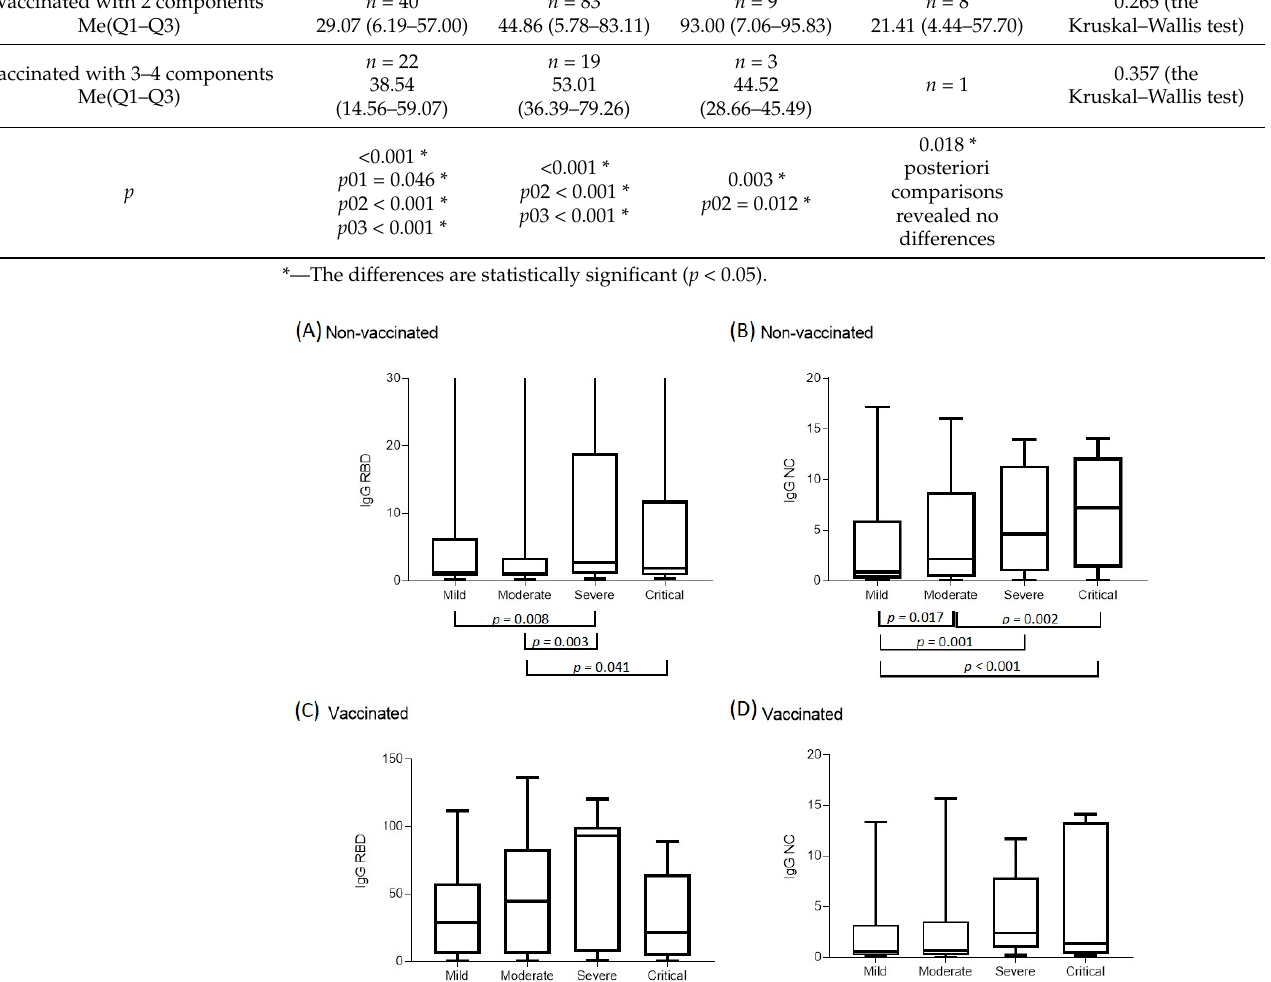
Figure 2. Levels of IgG antibodies in the RBD domain and NC protein depending on severity. Two groups are presented—unvaccinated and vaccinated with two components of Sputnik V. The Y-axis indicates the number of antibodies (PC), and shows the median, upper, and lower quantiles. The unvaccinated samples are characterized by a wide variation in the level of IgG antibodies in the RBD domain of the S protein. ( A )—shows the level of antibodies IgG RBD in unvaccinated patients, ( B )—the level of IgG NC in unvaccinated patients, ( C )—the level of IgG RBD in vaccinated patient and ( D )—the level of IgG NC in vaccinated patients.